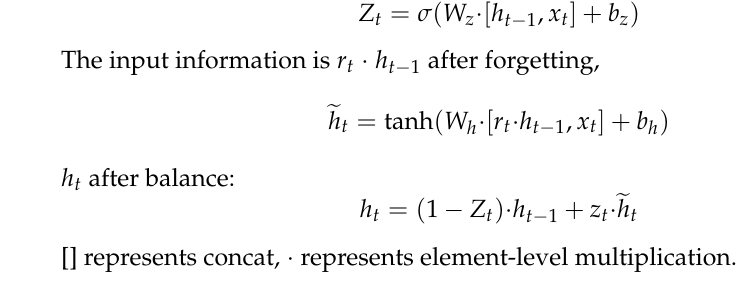
Table 1. Number of parameters of the compared models.